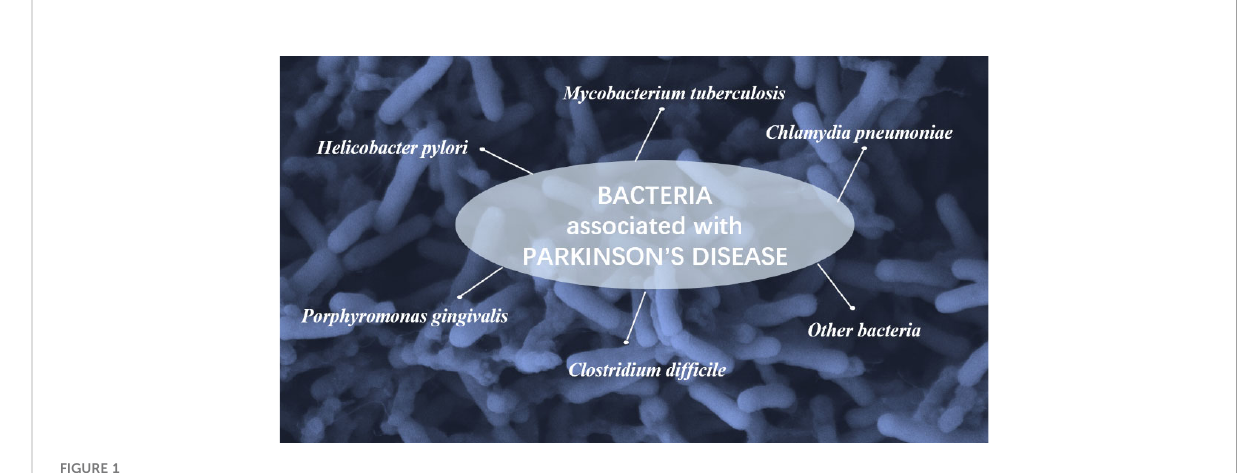
FIGURE 1 Main bacteria associated with